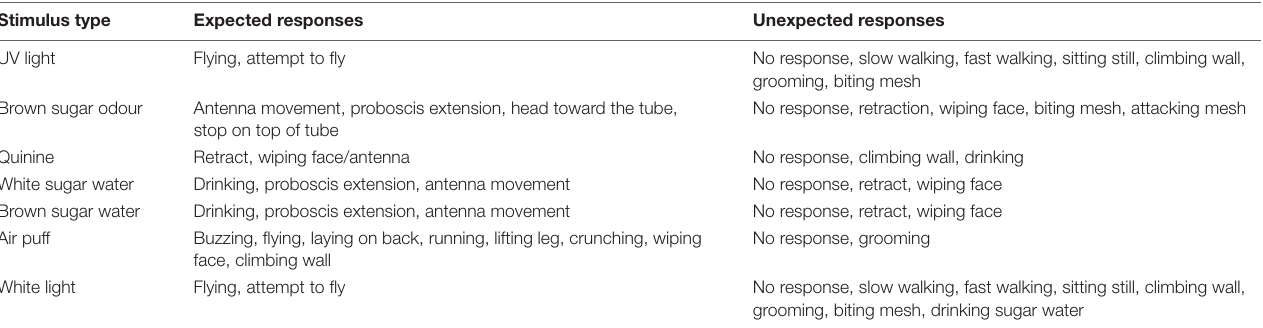
FIGURE 2 | The effect of developmental heatwaves on the behavioural response to sensory stimuli. The proportional of expected and unexpected behavioural responses ( Table 2 ) of bees exposed to (A) air puff, (B) brown sugar water, (C) honey odour, (D) quinine, (E) UV light, (F) white light (G) white sugar water. (H) Total proportion of expected and unexpected behavioural responses for all presented stimuli. Sample size = 59. TABLE 2 | Ethogram of correct and incorrect behavioural responses to various sensory